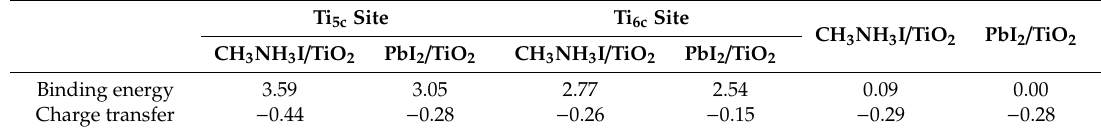
Table 4. Interfacial binding energy (in eV) of the Nb-substituted and pristine CH 3 NH 3 PbI 3 / TiO 2 interfaces.